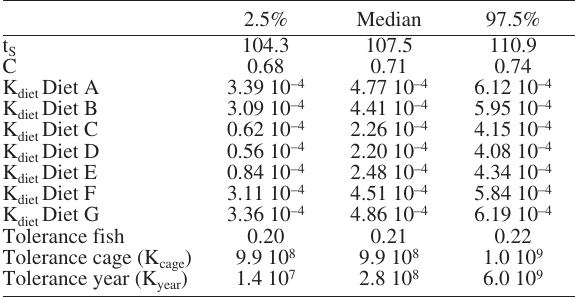
Table 3. – Posterior descriptors (median and 95% credibility inter- is given in days and val) of the relevant model parameters, where t S K in days –1 . Variability at fish, cage and year levels is indicated by tolerance (1/variance). Note that variability of K and K is cage year small. 2.5% Median